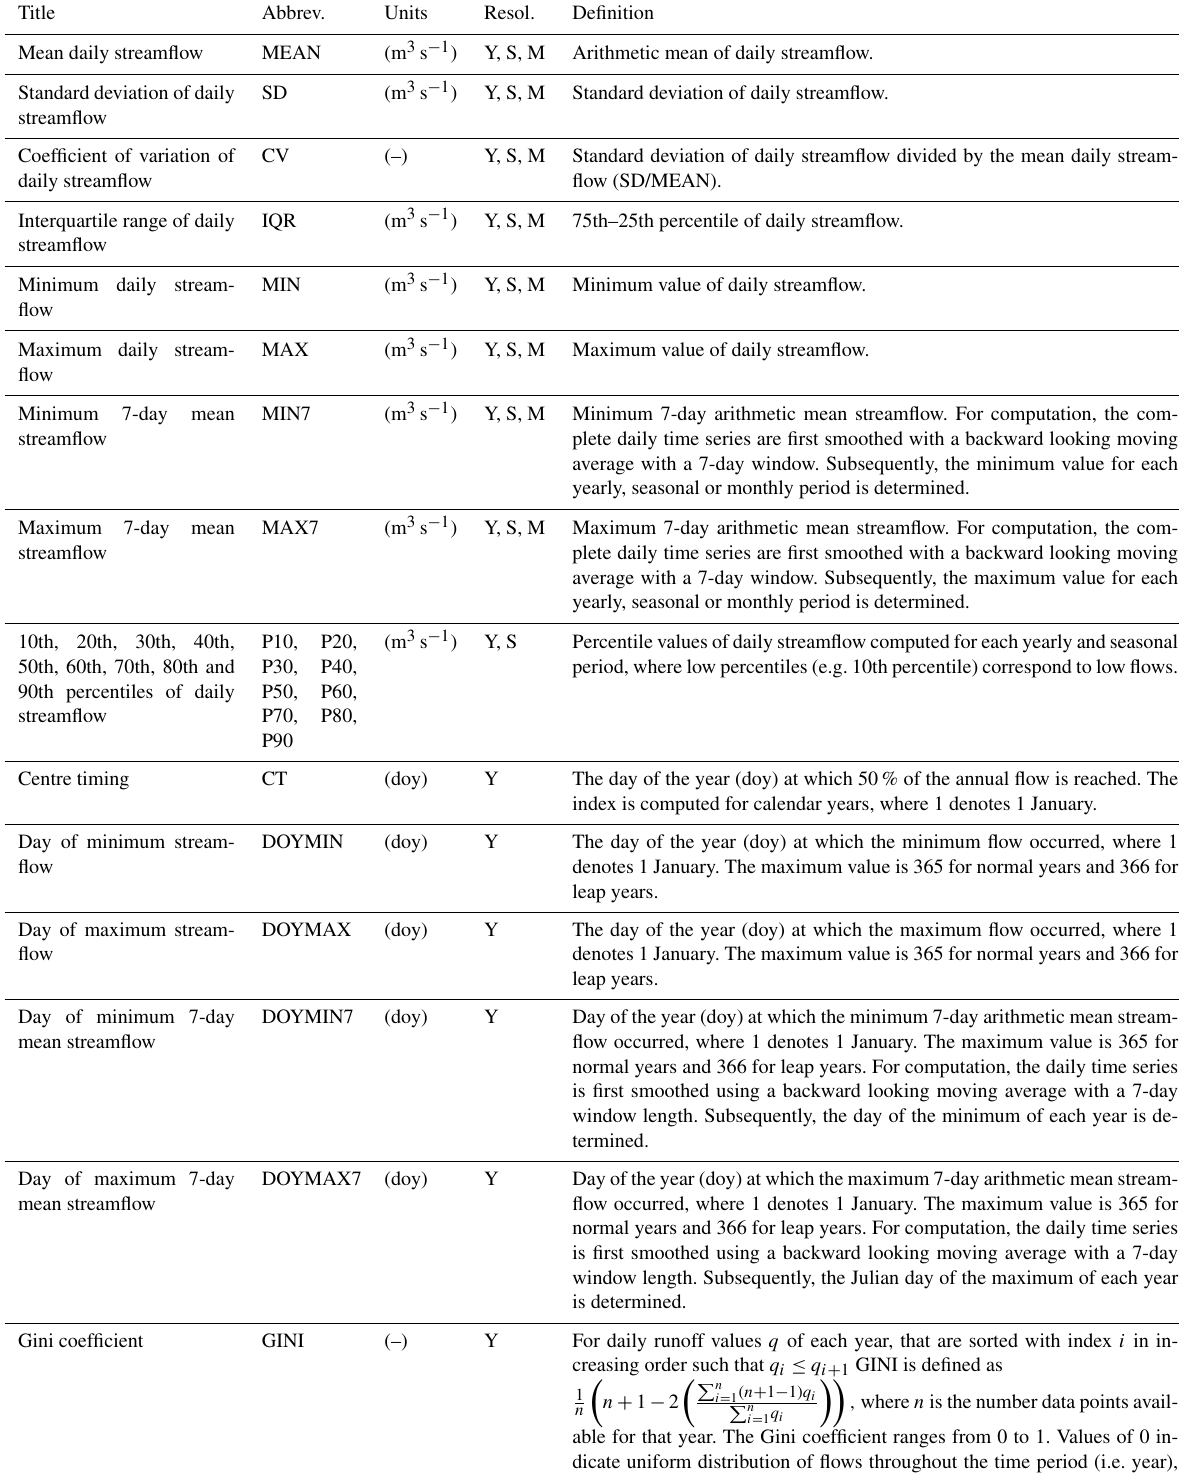
Table 3. Definition of time-series indices contributing to the GSIM archive. Abbrev. Indicates the abbreviation of the index name used throughout this paper as well as in the database. Resol. indicates the time resolution for which the index is computed, which can take values of Y (yearly), seasonal (S) and monthly